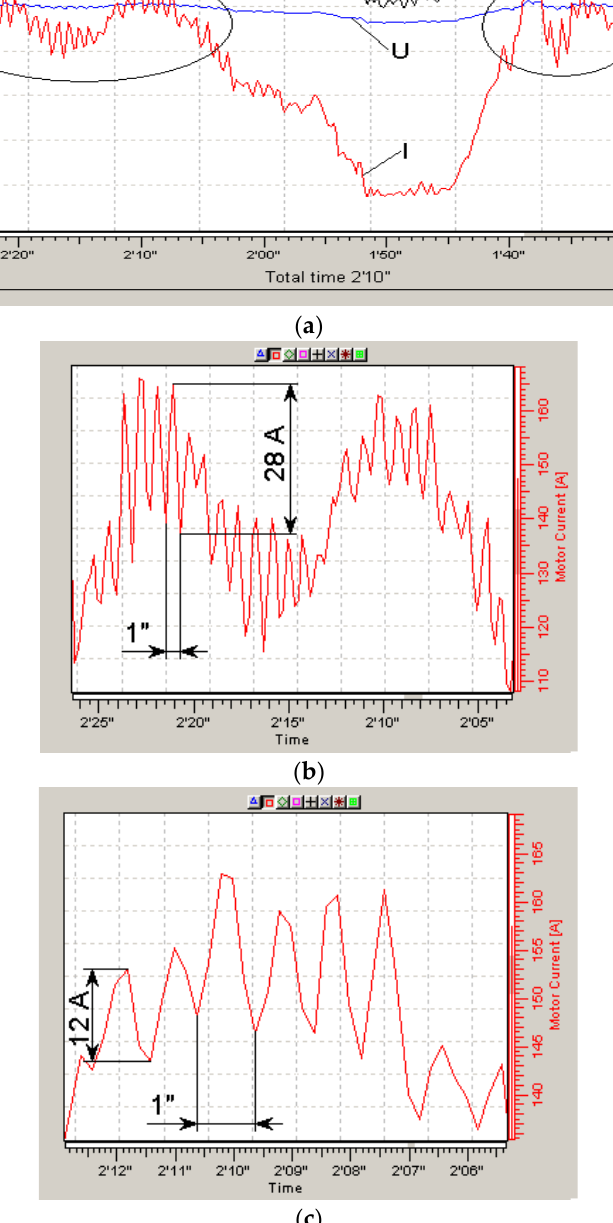
Figure 6. Diagrams of movement at medium speed along track 3 with parameters U = 500 V, f = 35 Hz and U/f = 14.3 Fl ( a ) and extended sections 1 ( b ) and 2 ( c ) of the current diagrams.